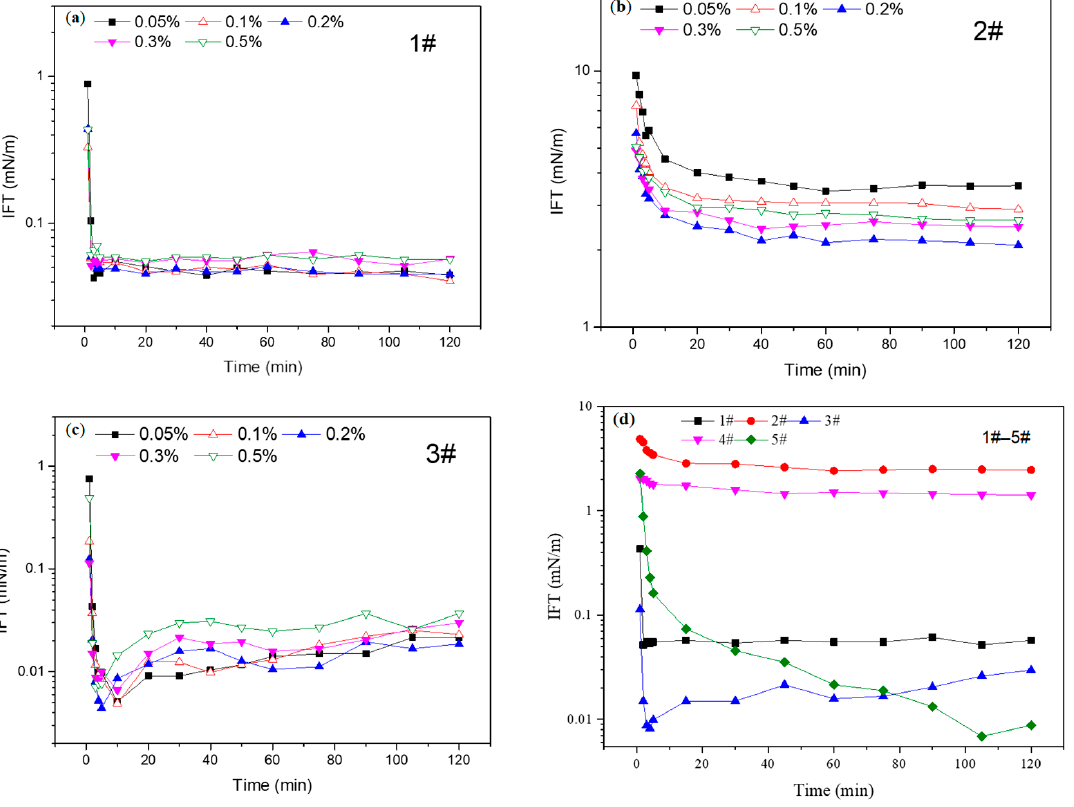
Figure 1. Interfacial tension of different viscosity reducers. ( a ) 1#, ( b ) 2#, ( c ) 3#, ( d ) 1#–5# with a concentration of 0.3%.